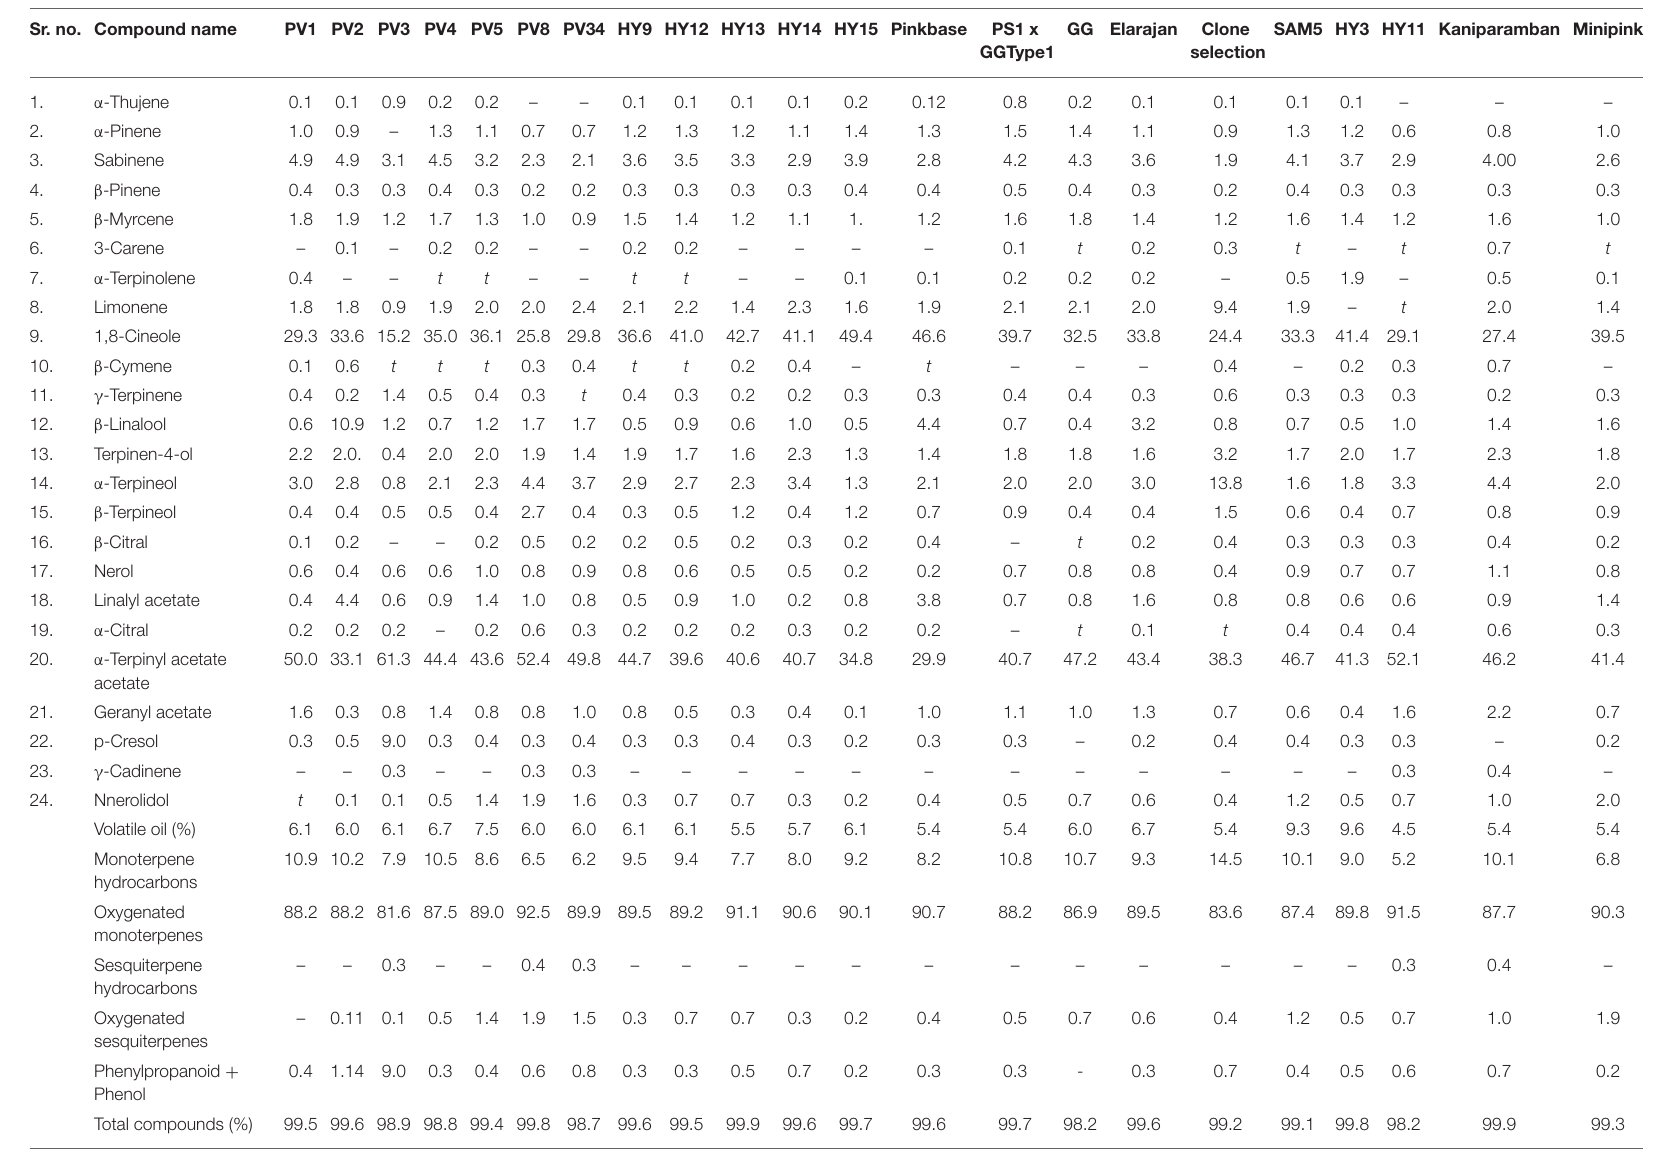
TABLE 2 | Essential oil composition in 22 promising cardamom